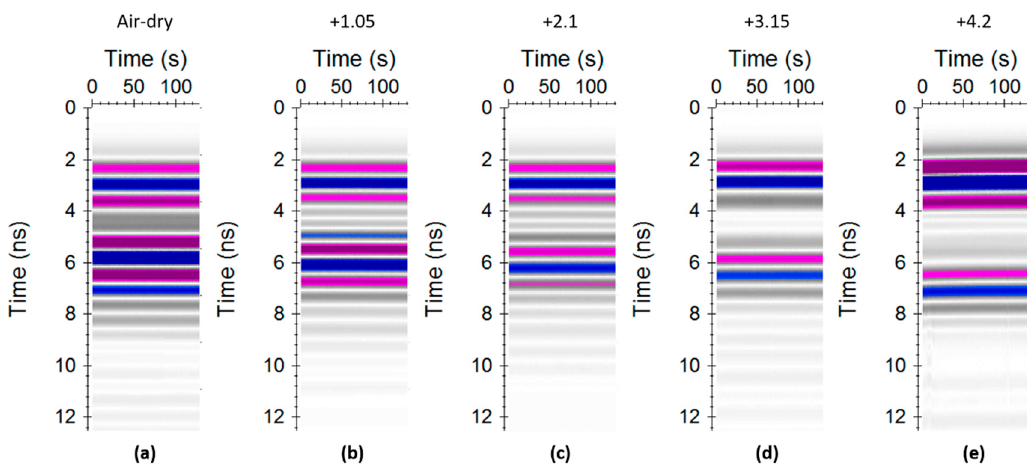
Figure 5. GPR section of calibration of the soil box experiment; the amplitude scale is on the right. ( a ) Specific wiggle trace; ( b ) GPR profile of static measurement. The upper orange line is time zero (t 0 ), and the lower orange line is the reflection from the metal bottom (t 1 ).